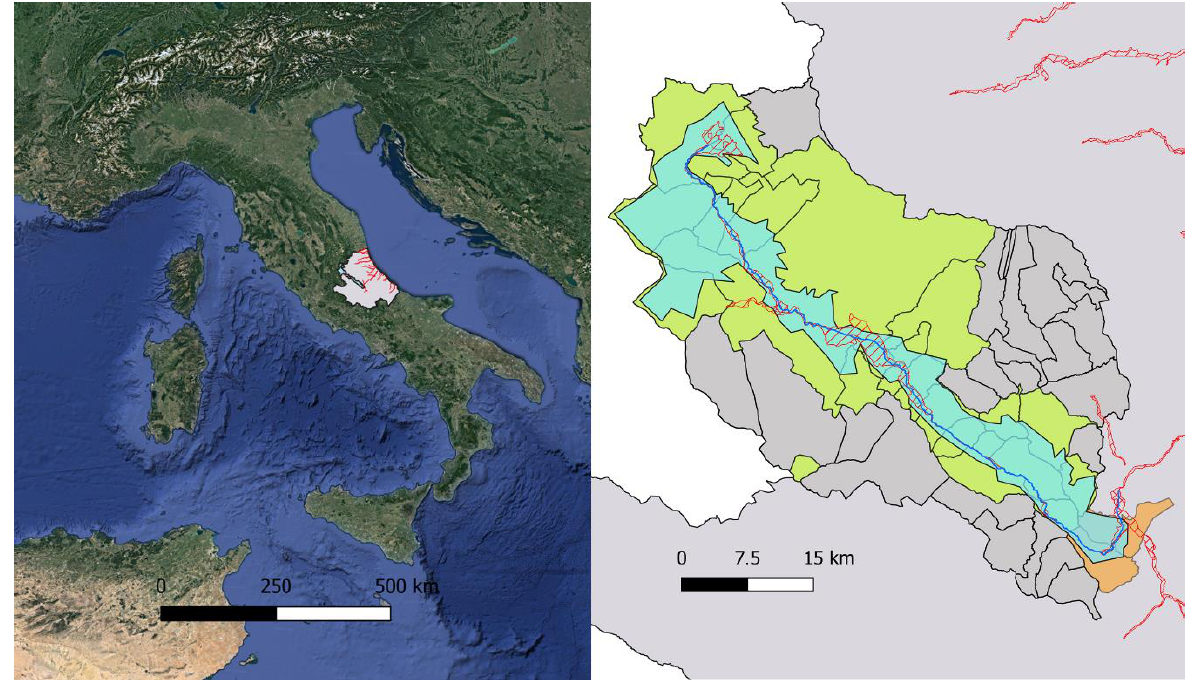
Figure 2. Satellite cartography of Italy with, on the right, an enlargement of the area relating to the Aterno River basin (with the areas subject to flooding highlighted with red outlines).